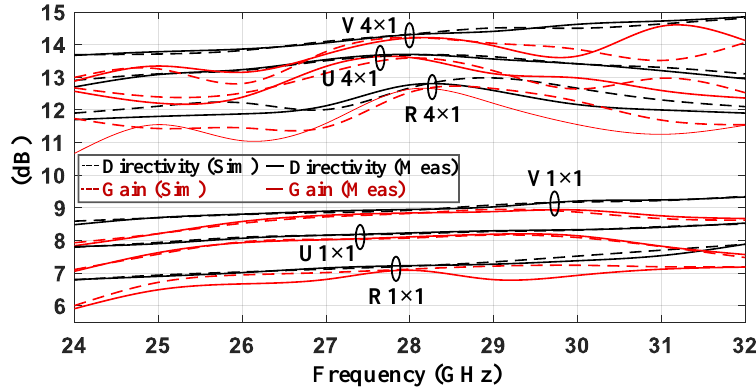
Figure 10. The simulated / measured gain / directivity versus frequency for the fabricated Figure 10. The simulated/measured gain/directivity versus frequency for the fabricated prototypes. Figure 10. The simulated/measured gain/directivity versus frequency for the fabricated prototypes. Figure 10. The simulated/measured gain/directivity versus frequency for the fabricated prototypes.